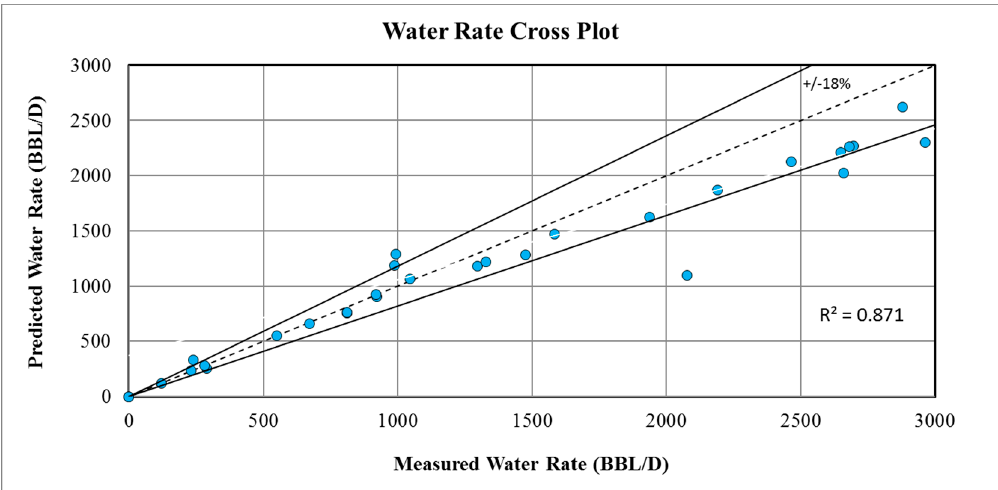
Figure 15. Predicted vs measured water rate using the Colebrook correlation.